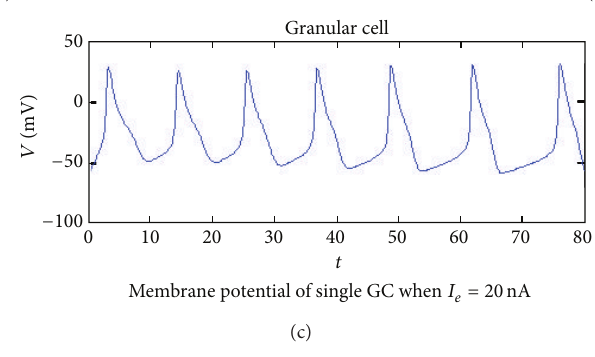
Figure 3: Spike trains of a GC under different